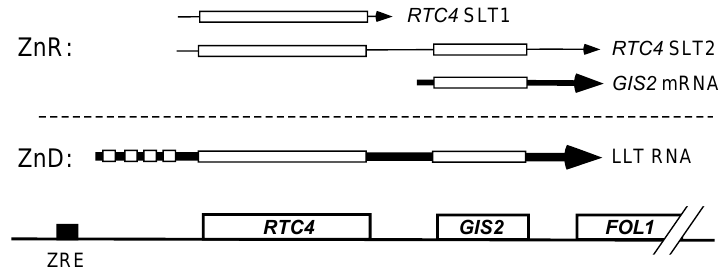
Figure 2. Model of RTC4 and GIS2 co-regulation by a bicistronic regulatory RNA. Arrows indicate RNAs produced and the boxes denote open reading frames (ORFs). Several small ORFs located in the region between the RTC4 and GIS2 protein-coding regions are not shown. ZnR and ZnD denote zinc-replete and zinc-deficient growth conditions, respectively. SLT1/2 and LLT refer to short leader transcripts and long leader transcripts, respectively. The box labeled ZRE indicates the location of a zinc-responsive element.